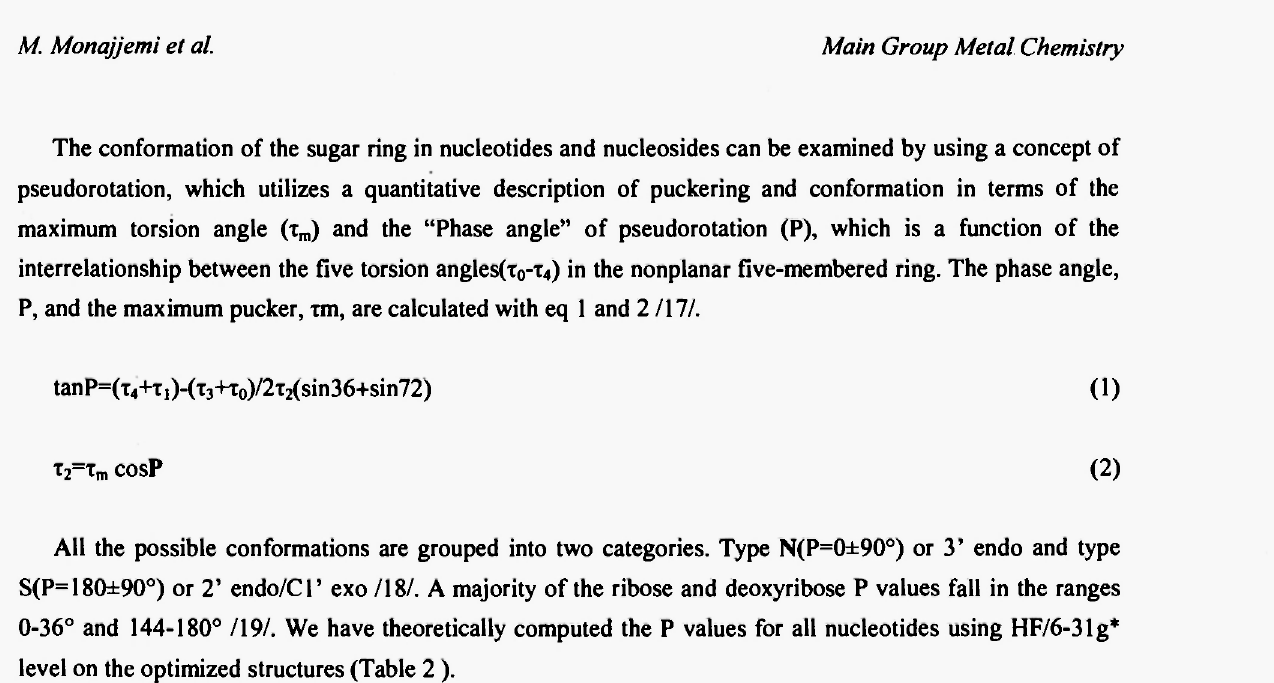
Dihedral Angles complexes at 6-31g* basis set.